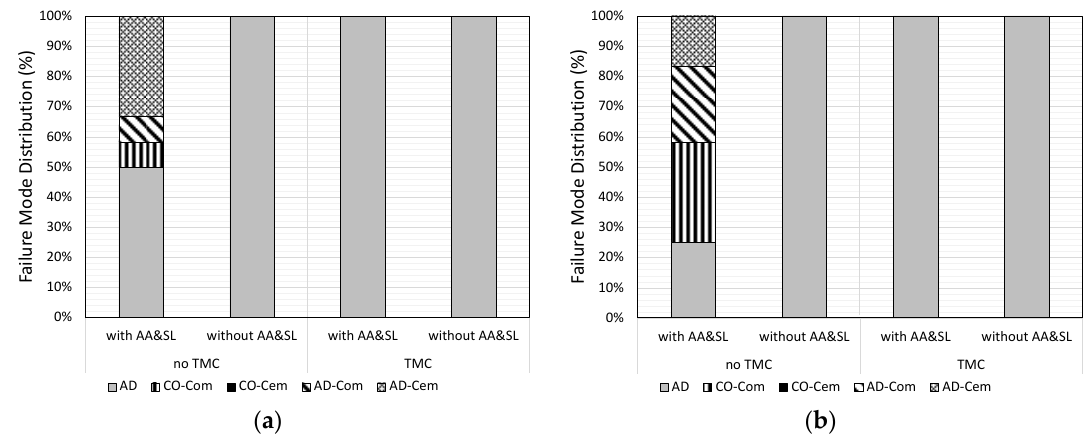
Figure 6. Failure modes of the specimens for ( a ) Shofu HC Hard (SH) and ( b ) Cerasmart 300 (CE) after the shear bond strength tests. AA&SL: alumina air-abraded and silanized specimen. TMC: 20,000-thermocycled specimen. No-TMC: 0-thermocycled specimen. AD: adhesive failure, CO-Com: cohesive failure in composite, CO-Cem: cohesive failure in cement, AD-Com: mixed failure adhesive + cohesive in composite, AD-Cem: mixed failure adhesive + cohesive in cement.